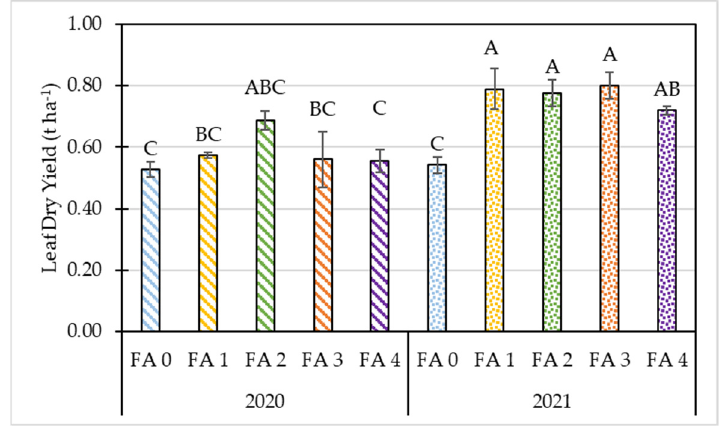
Figure 4. Influence of interaction Y × FA on leaf dry yield. FA 0: only water; FA0: only water; FA1: 8 g L − 1 of CaO; FA2: 12 g L − 1 of CaO; FA3: 8 g L − 1 of CaO + 16 g L − 1 of urea; FA4: 12 g L − 1 of CaO + 16 g L − 1 of urea. Values with different letters are significantly different at p ≤ 0.05 according to Tukey’s test. Bars represent the standard deviation.